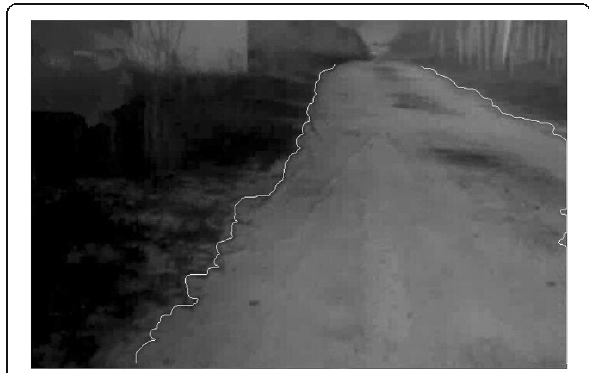
Fig. 11 FCM clustering road boundary recognition result based on probability confidence map